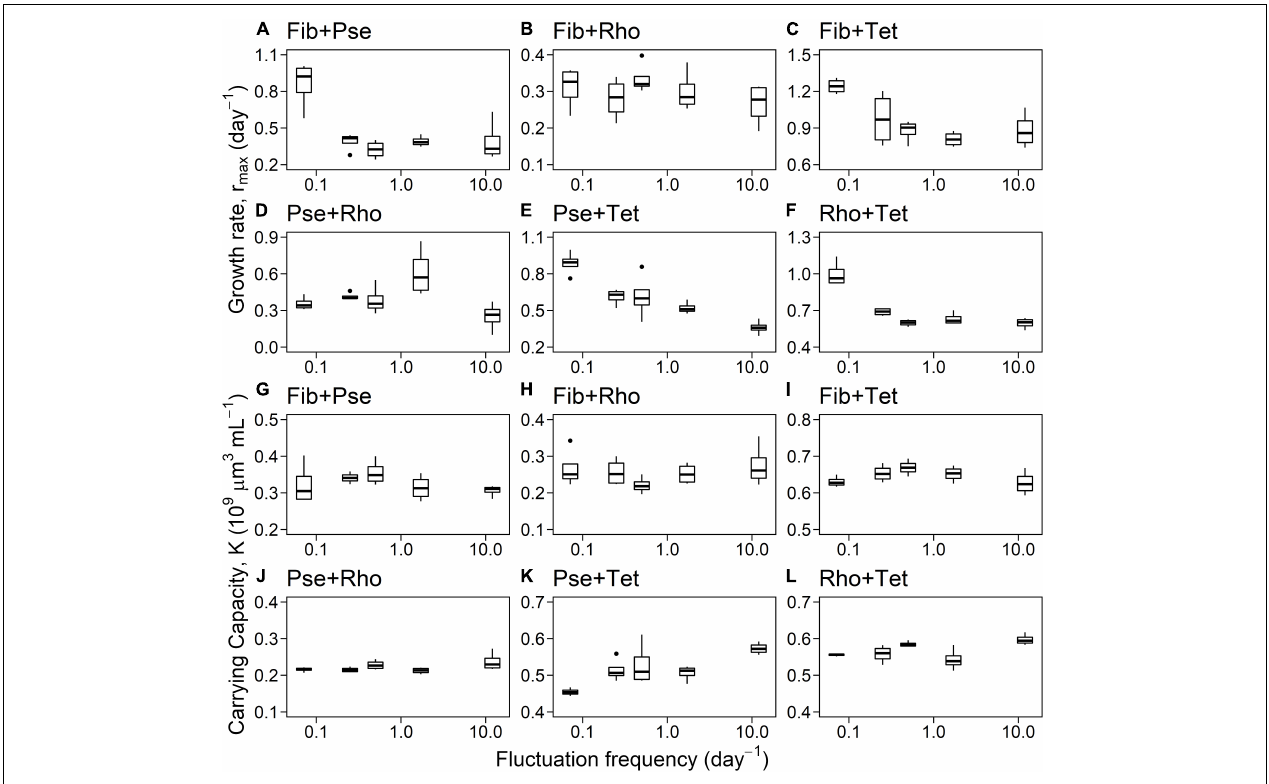
FIGURE 6 | Maximum growth rates (A–F) and carrying capacity (G–L) for two-species mixtures related to fluctuation frequency (log-scale).